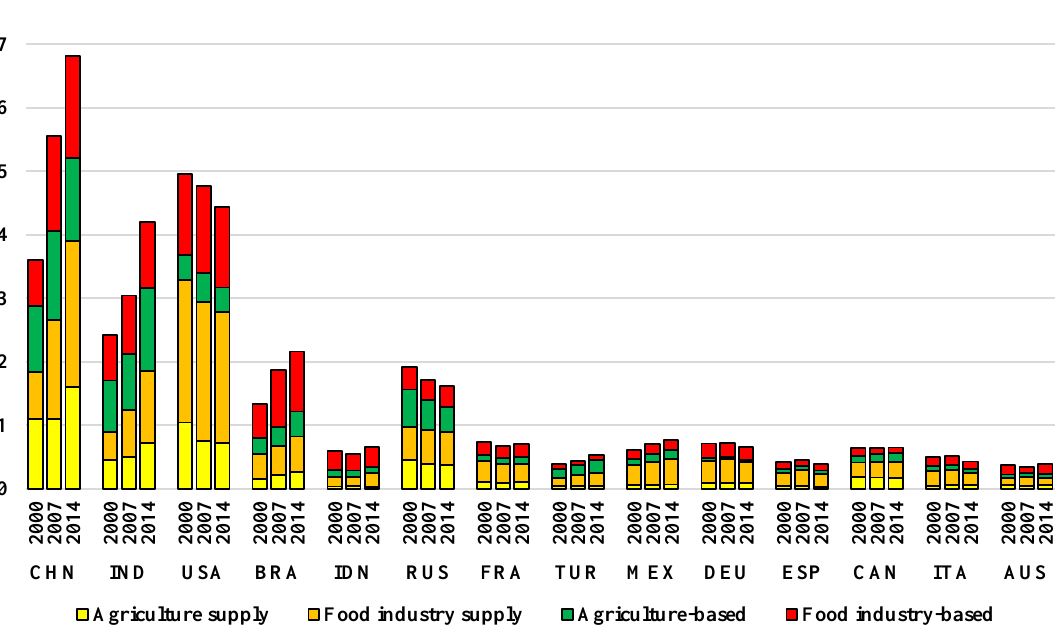
Figure 1. Energy consumption in food production chain in the selected countries (values in exajoules).